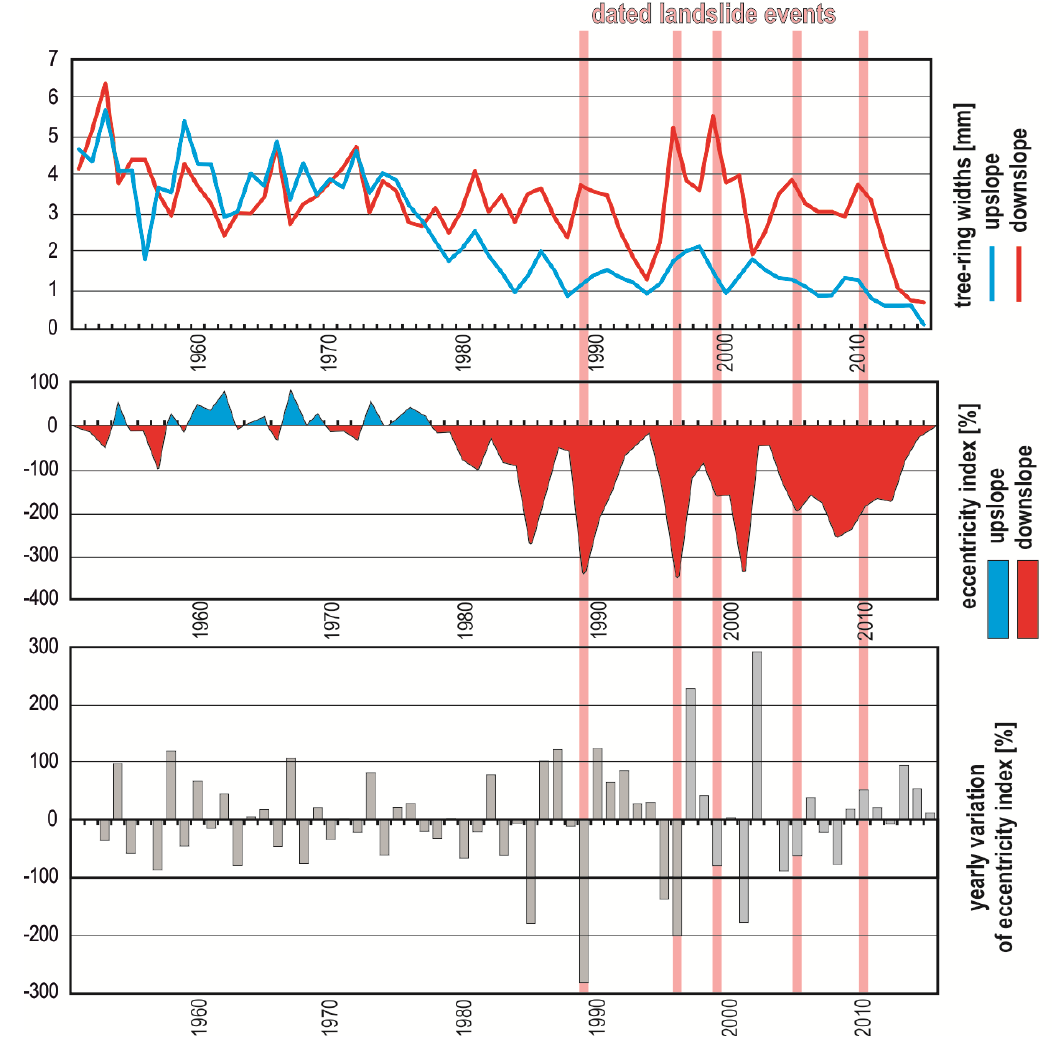
Fig. 3. Dating of landslides recorded in the stem of a single Norway spruce from the study area: tree ring widths [mm], eccentricity index [%] and its yearly variation